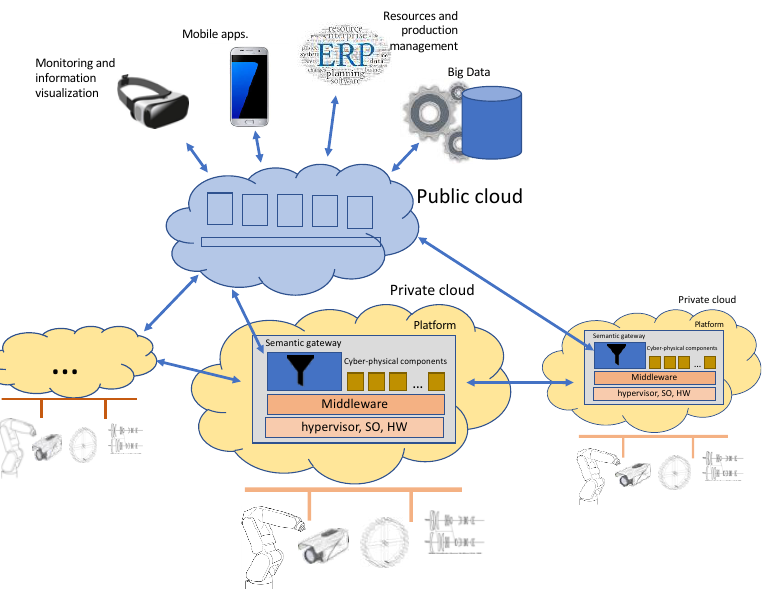
Figure 1. General view of a system for industry digitalization.